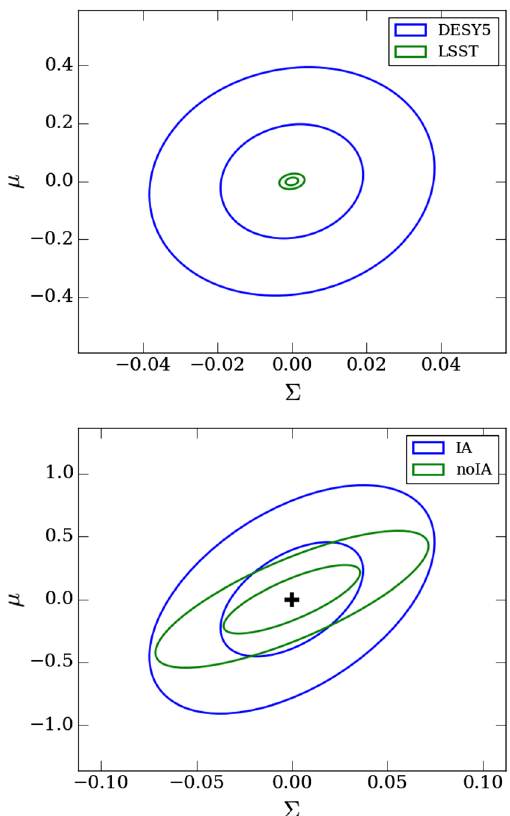
Fig. 17 Left: Forecasted 68% and 95% confidence contours on MG parameters Σ and μ for a future DES-Y5 survey in blue and for an LSST-like survey in green. No intrinsic alignment (IA) systematics are assumed here. While DES-Y5 promises to make tight constrains on Σ as expected from a weak lensing survey, LSST will provide an order magnitude further improvement on the two parameters. Right: A comparison between uncertainties for DES-Y5 survey when ignoring IA in green and taking them into account in blue. This means that ignoring IA leads to underestimating the uncertainties on the parameters. This also shows that these uncertainties will be systematic-error dominated. Figure reproduced with permission from Ferté et